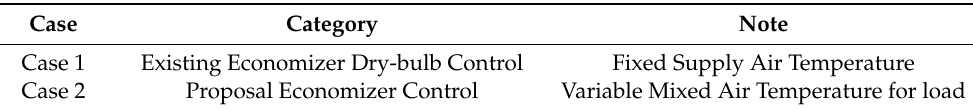
Table 7. Simulation